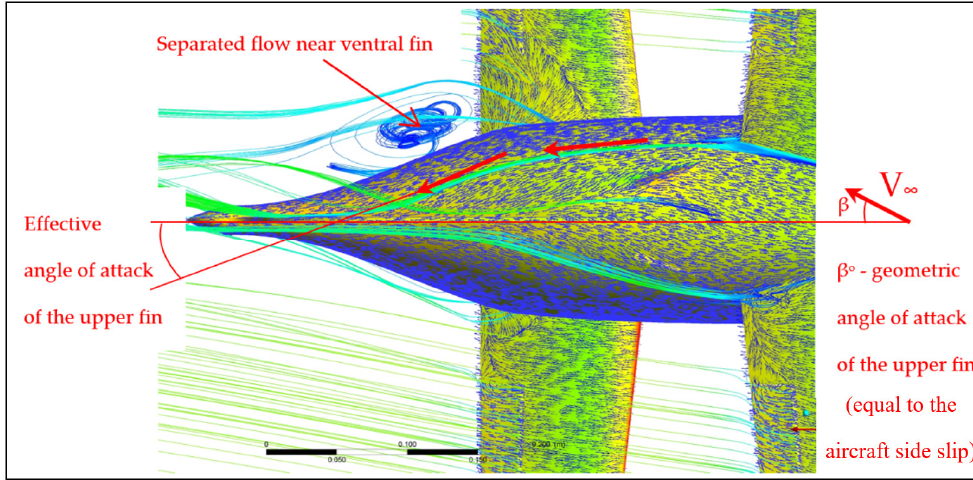
Figure 14. Top view of velocity streamlines at β = +9° revealing a negative effective angle of attack of the upper fin and a 3D vortex near the separated ventral fin.